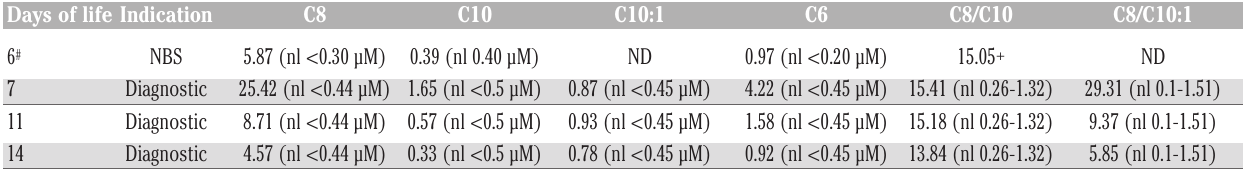
Table 1. Newborn screening and diagnostic acylcarnitine values.